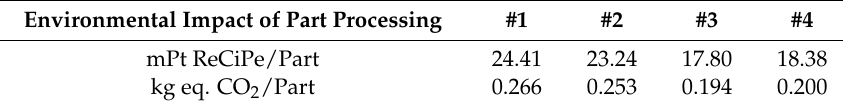
Table 4. Scenarios Assessment: Environmental impact of processing a plastic